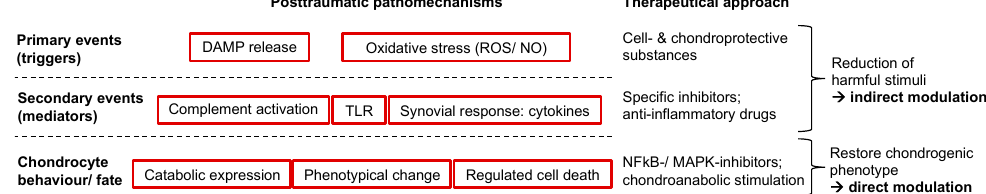
Figure 3. Therapeutic targeting of posttraumatic pathomechanisms. The behavior and fate of chondrocytes might be modulated on different levels: upstream, the attenuation or elimination of harmful triggers and mediators (indirect modulation); downstream, addressing the cellular response itself by selective inhibition of unwanted processes or chondroanabolic stimulation (direct modulation).